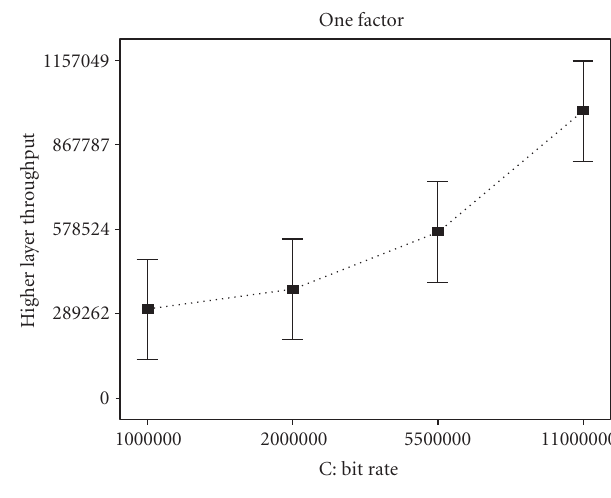
Figure 6: Analysis of bitrate’s e ff ect on FTP throughput.